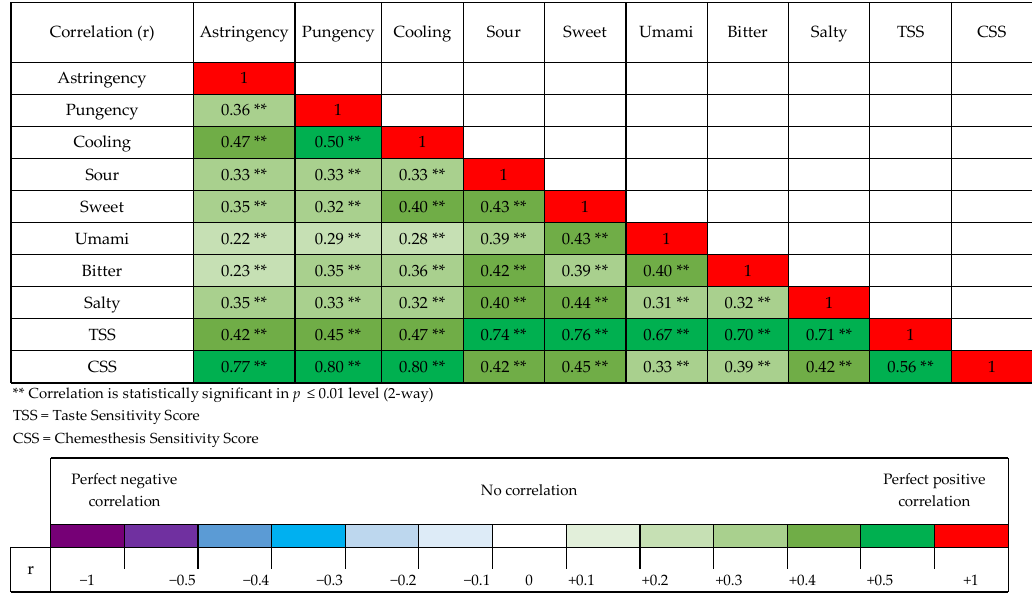
Figure 2. The Pearson correlation matrix between chemesthesis and taste variables N = 189. In the matrix, the numeric r-value and color-coding indicate the level of correlation with tested factors. The taste qualities and sensitivity score were measured earlier [14]. Table 5. The statistically significant odds ratios (OR) for chemesthetic modalities in sensitivity explained by taste modalities by the multinomial logistic regression ( N = 189). The explaining taste modalities were analyzed separately to keep the reliability of the